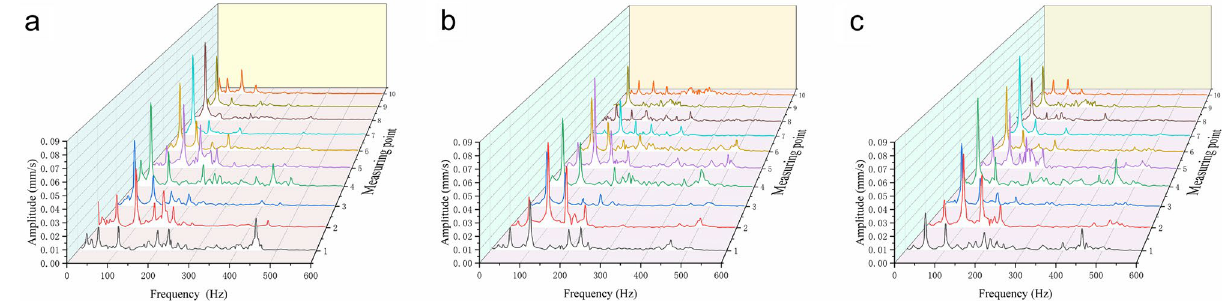
Figure 12. Velocity distribution in frequency-domain of 10 measuring points at ( a ) 0.8Q d , ( b ) 1.0Q d , ( c )1.2Q d .